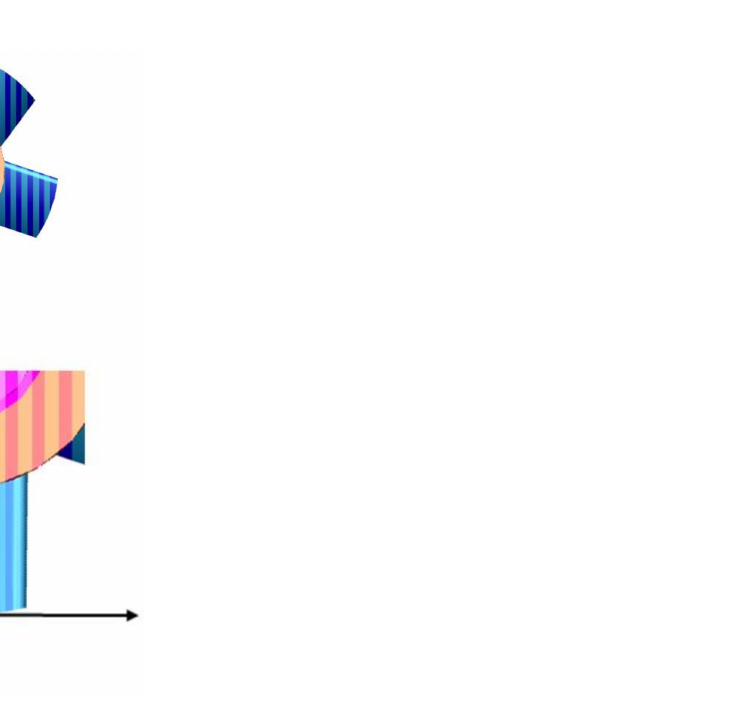
Figure 4. Textures on the surface of micro-sized part by laser scanning. ( a ) Laser light scans the surface of the micro-sized part and transfers the image to the software system. ( b ) The theoretical texture of the surface of the micro-sized part. ( c ) The theoretical texture of the surface of the micro-sized part